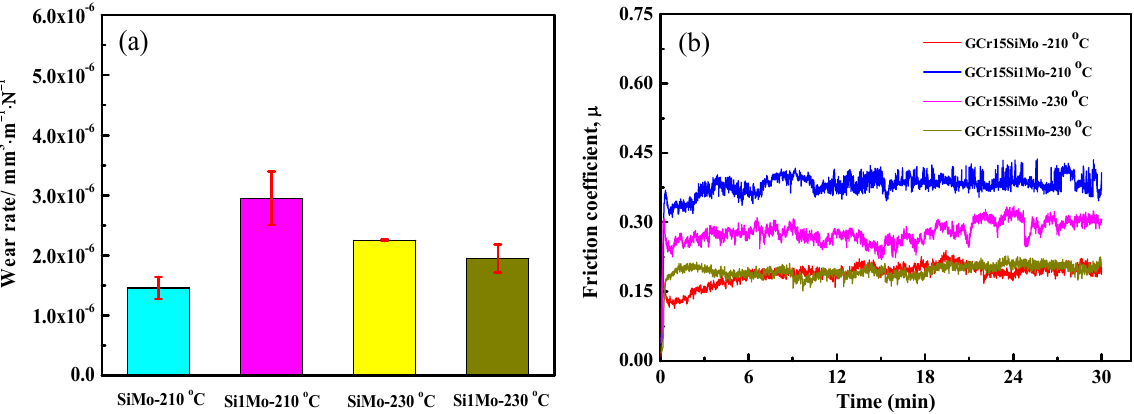
Figure 11. Friction and wear results of the steels austempered at different temperatures for 8 h: ( a ) average wear rate; ( b ) friction coefficient vs. sliding time.